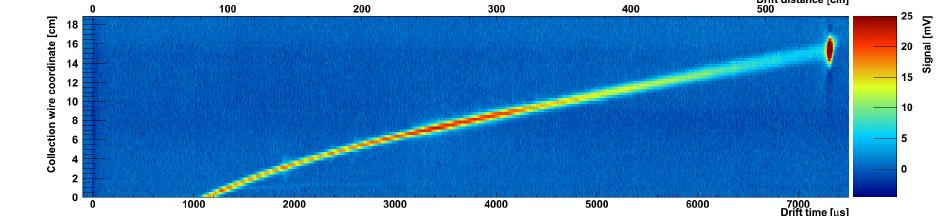
Figure 4. Ionization tracks caused by UV laser beam in a 5 m long drift liquid argon TPC. 100 tracks superimposed. Reproduced with permission from [25].